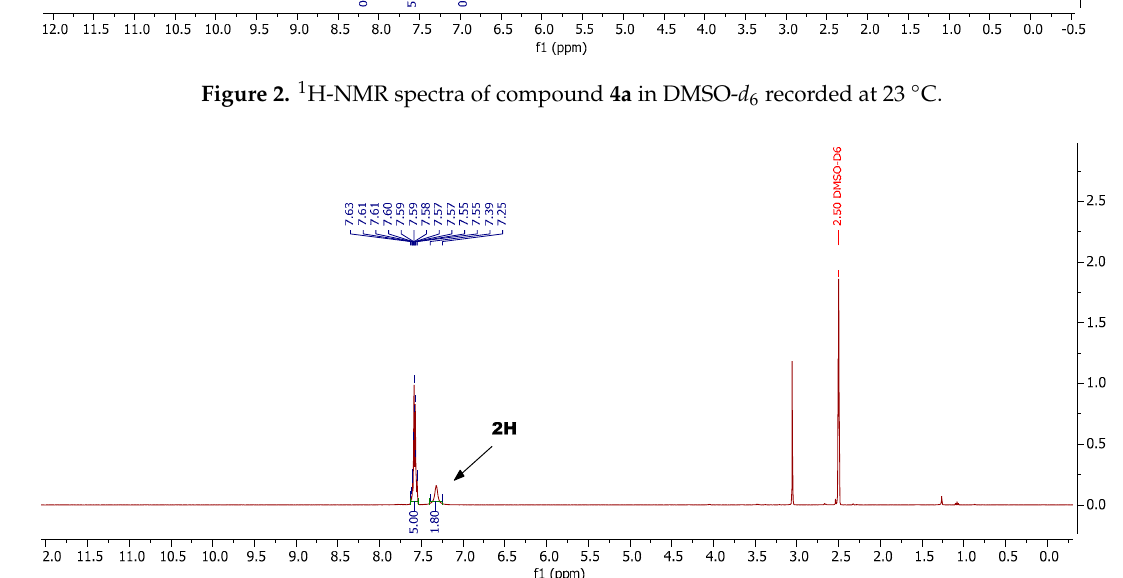
Figure 3. 1 H-NMR spectra of compound 4a in DMSO- d 6 recorded at 80 °C.